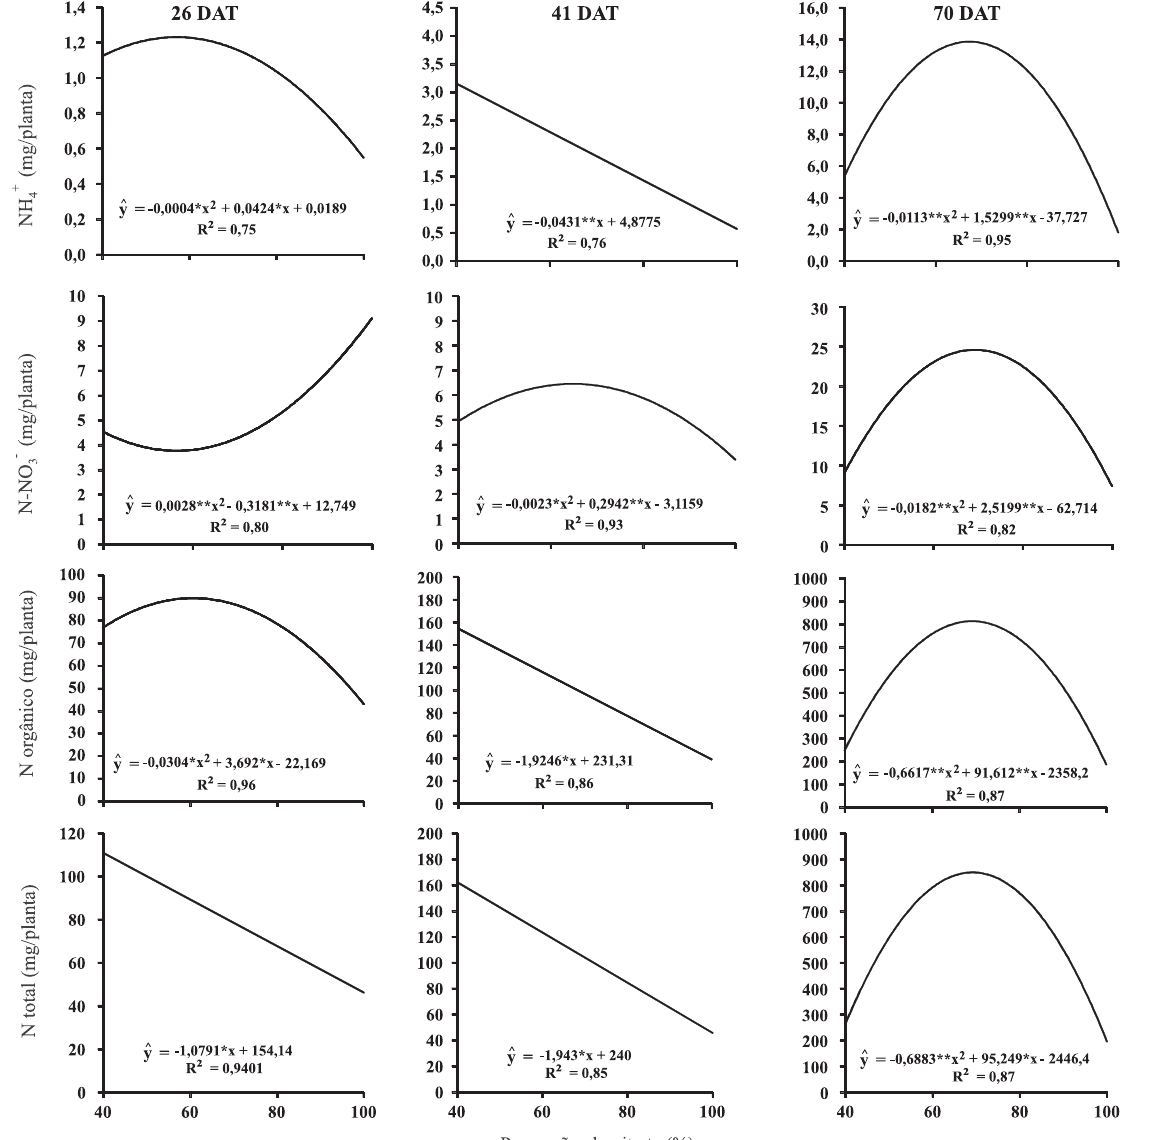
figura 4. totais acumulados de nitrogênio total (n-total), orgânico (n-org), nítrico (n-no 3- ) e amoniacal (n-nH 4+ ) na matéria seca da cultivar brs Colosso em função das proporções de nitrato e dos estádios de crescimento. dAt: dias após o transplantio. ** ,* e ns: significativo em níveis de p < 0,05 e p < 0,01 e não significativo,